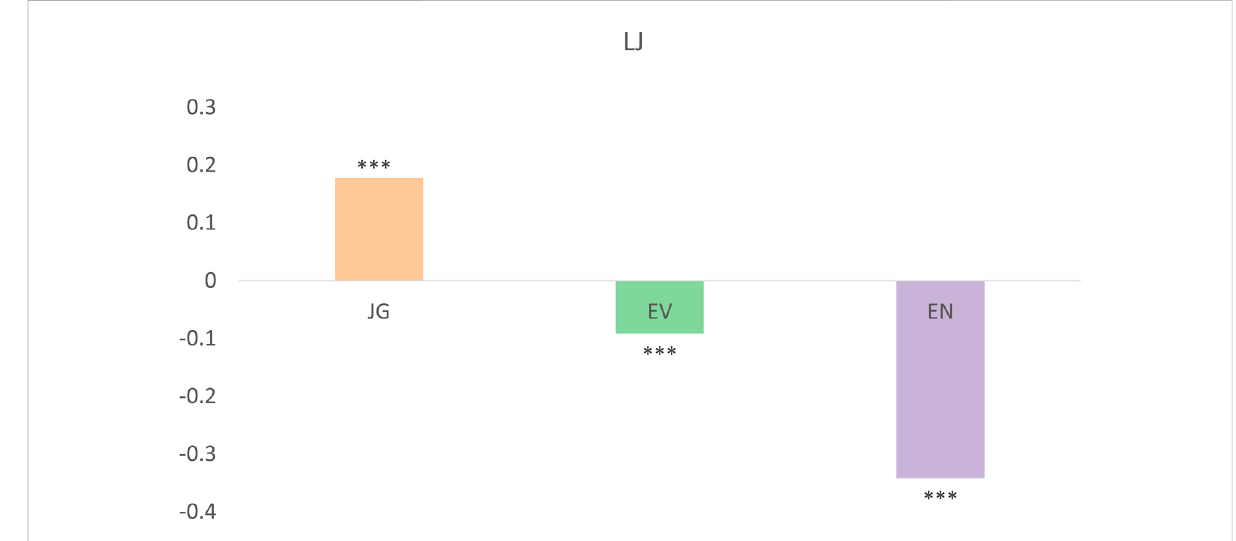
FIGURE 6 Benchmark regression results when control variables are not added (see Supplementary Table S4 for detailed